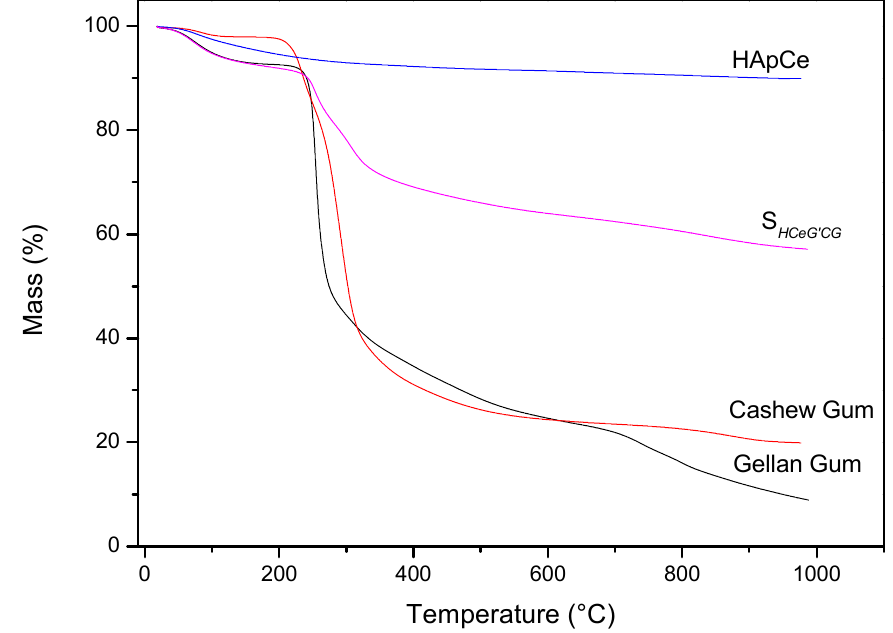
Figure 7. TG curves of precursors materials and S HG .